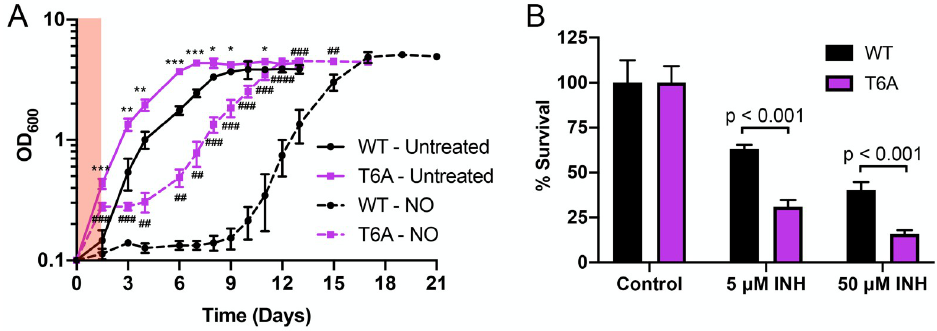
Fig 7. STPK phosphorylation of PrrA is critical for Mtb entry into an adaptive state of growth arrest upon extended NO exposure. (A) Blocking STPK phosphorylation of PrrA affects the ability of Mtb to enter a state of growth arrest upon extended NO exposure. PrrA-DUC/ Δ prrA (“WT”) and PrrA-T6A-DUC/ Δ prrA (“T6A”) were treated with 4 doses of 100 μ M DETA NONOate over 30 hours (red shaded region indicates period of treatment) and growth tracked over time. Data are shown as means ± SD from 3 experiments. p-values were obtained with an unpaired t-test, comparing PrrA-T6A-DUC/ Δ prrA to PrrA-DUC/ Δ prrA within each condition. � symbols indicate p- values for the untreated conditions. # symbols indicate p-values for the NO conditions. � p < 0.05, �� p < 0.01, ��� p < 0.001, ���� p < 0.0001. (B) The PrrA-T6A variant is more sensitive to isoniazid. Log-phase PrrA-DUC/ Δ prrA ("WT") and PrrA-T6A-DUC/ Δ prrA (“T6A”) Mtb were treated with isoniazid (INH) for 24 hours. Percent survival compares the number of CFUs from each INH treatment to the untreated control condition for each strain. Data are shown as means ± SD from three experiments. p-values were obtained with an unpaired t-test.